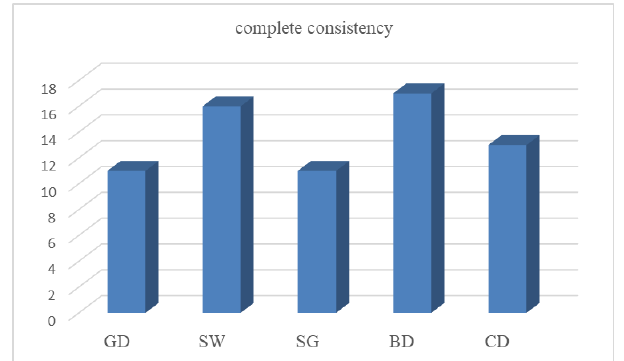
Figure 2 . Figure complete consistence rate.